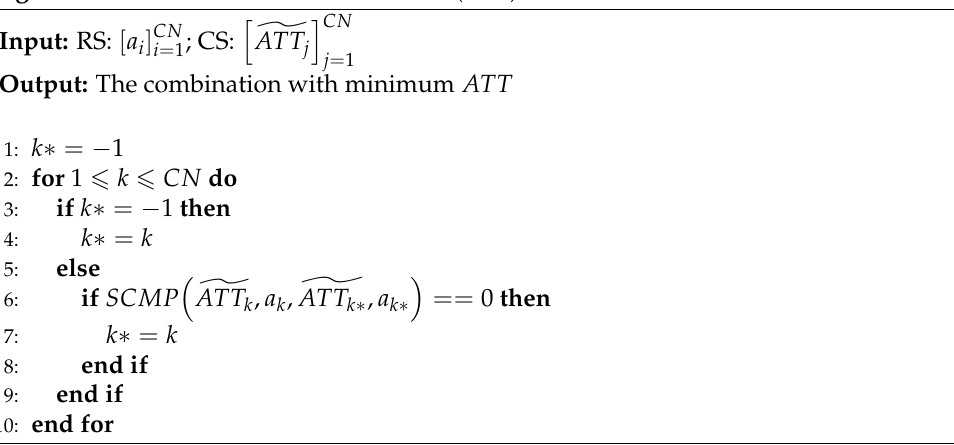
Algorithm 4 Rider Combination Selection ( RCS